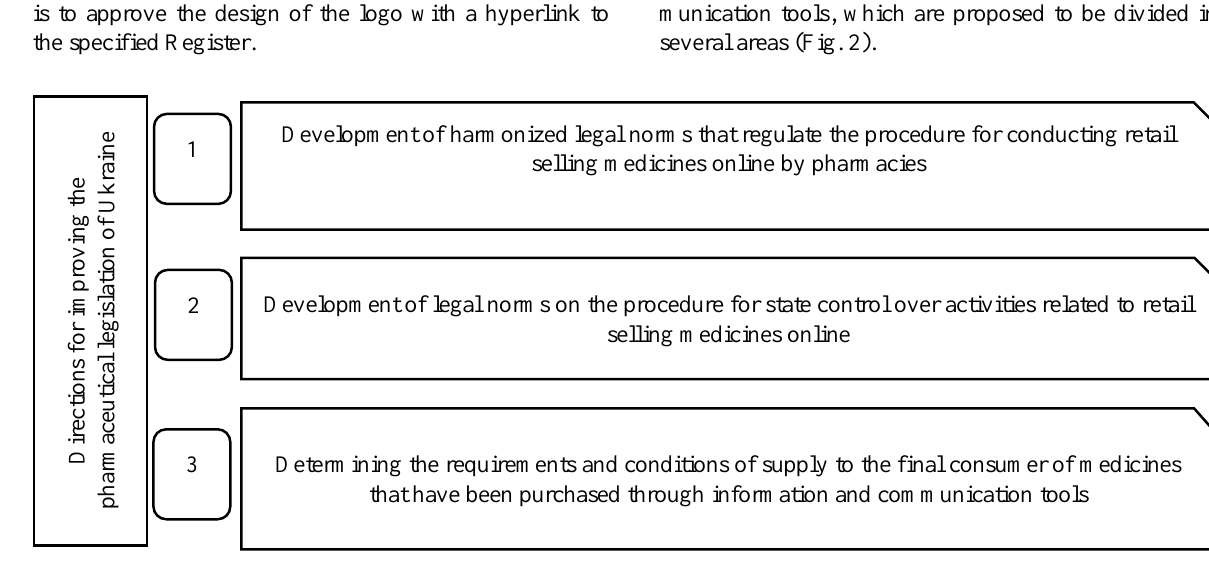
Fig. 2. Directions for improving the pharmaceutical legislation of Ukraine in the field of the online retail selling (distance selling) of